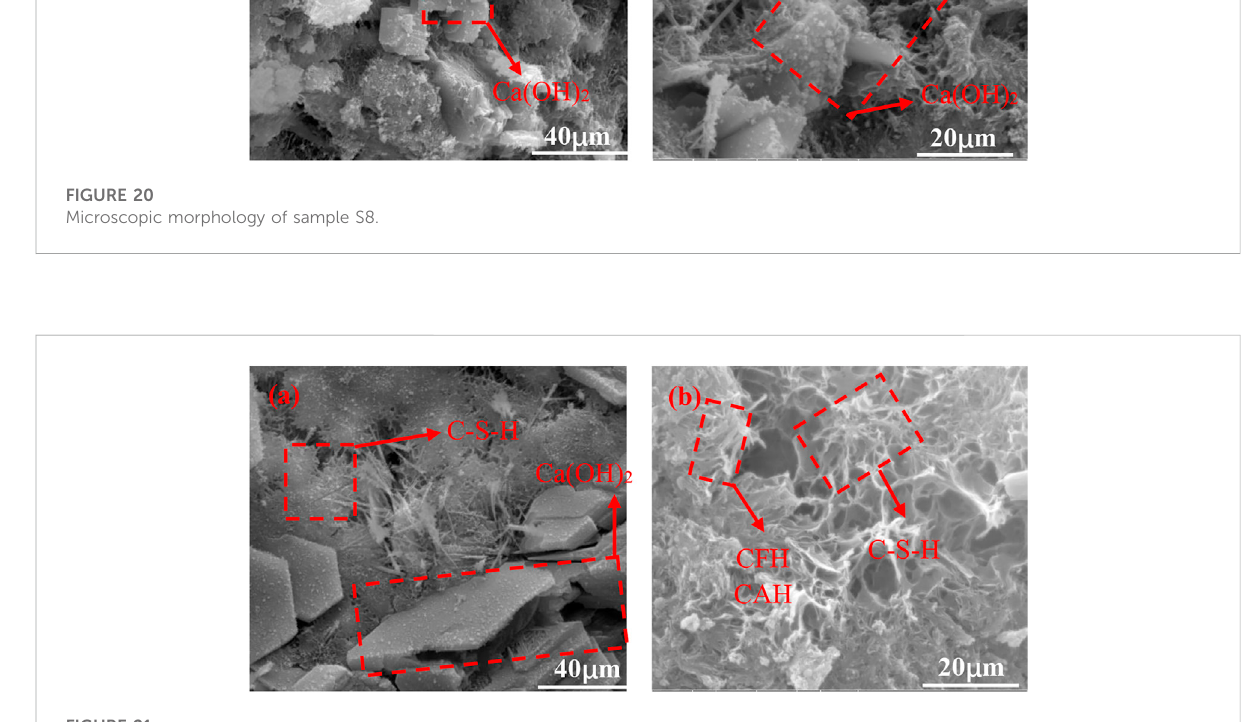
FIGURE 21 Microscopic morphology of sample